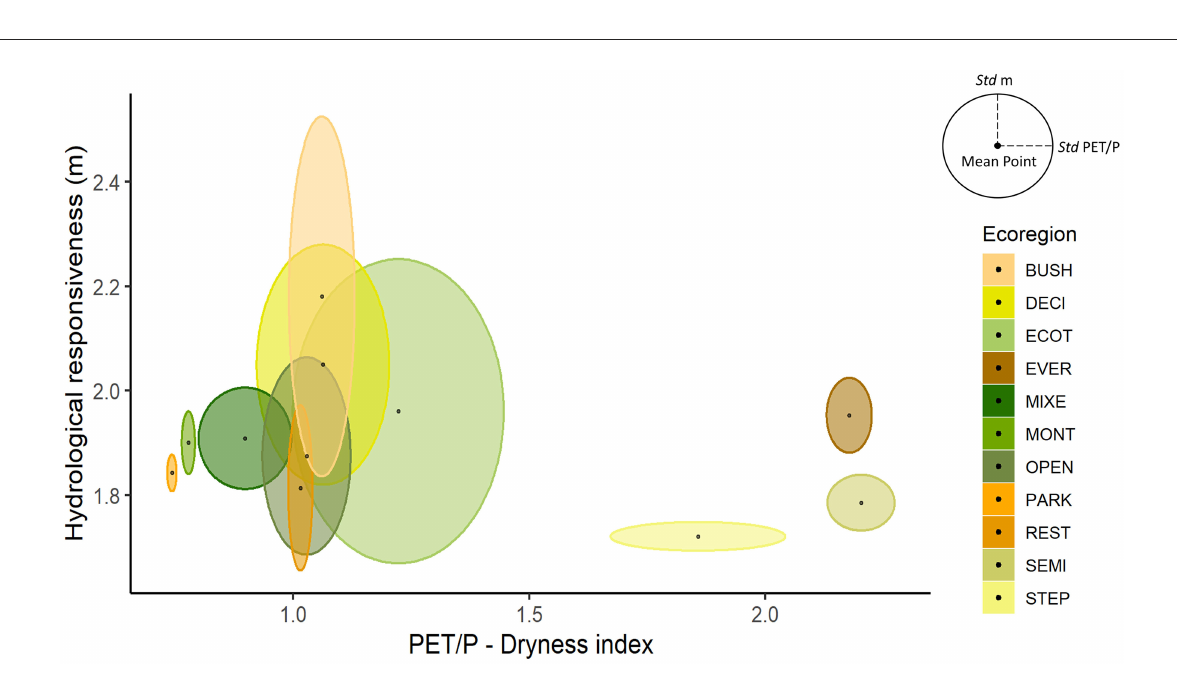
as Evergreen broadleaved forest (EVER), Mixed